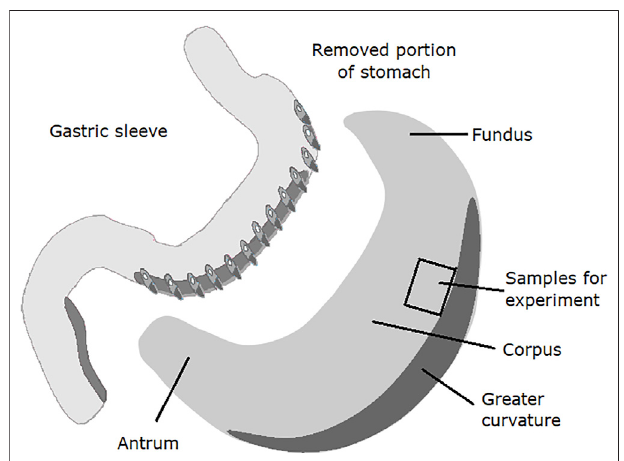
FIGURE 1 | Diagram of anatomical areas of the stomach after gastrectomy using the vertical sleeve method. The place of sampling for the conducted experiments was